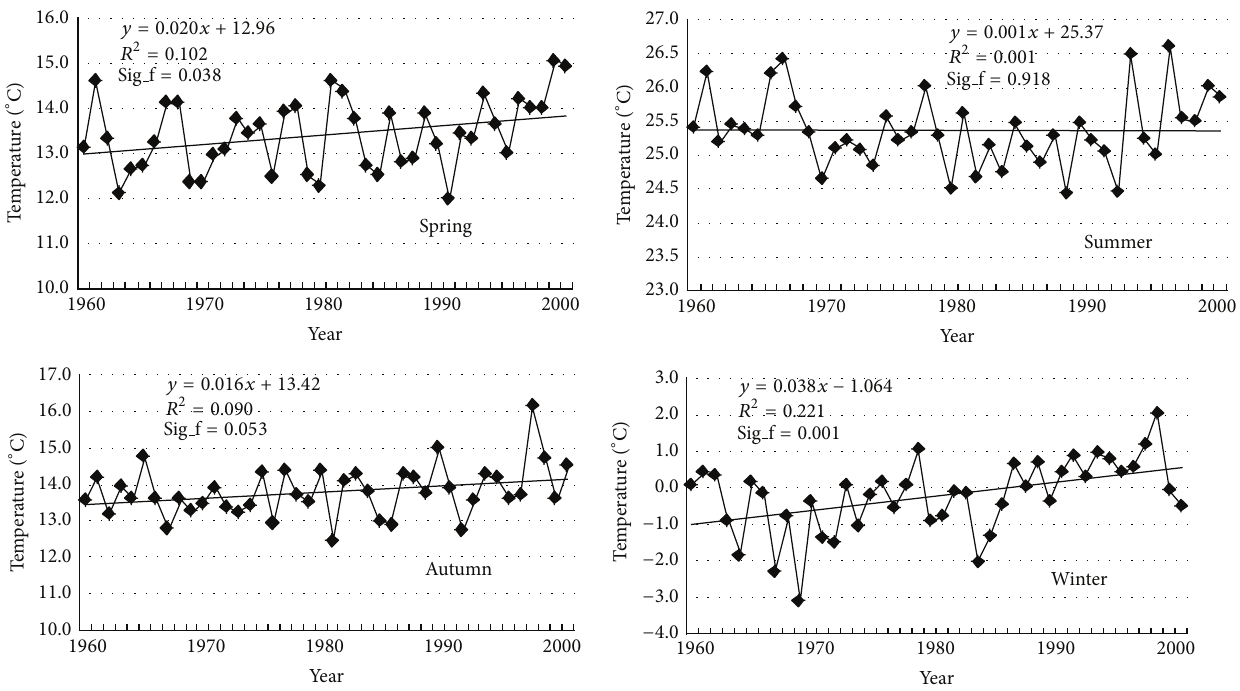
Figure 5: Interannual temperature change trend rates in the Lower Yellow River Region.